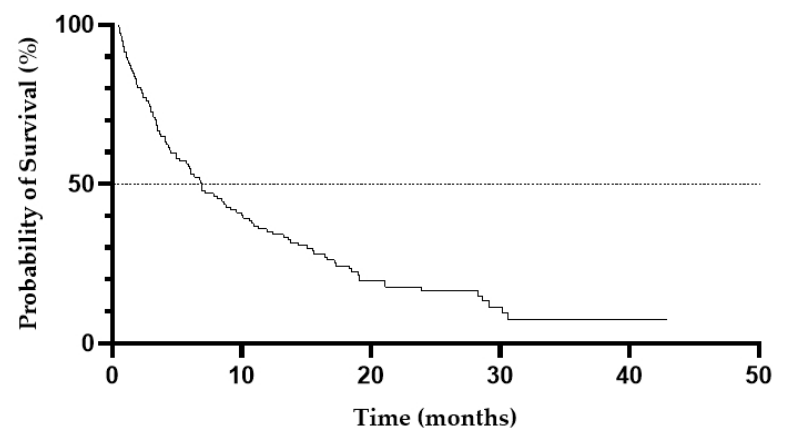
Figure 2. Overall survival for the entire study cohort.